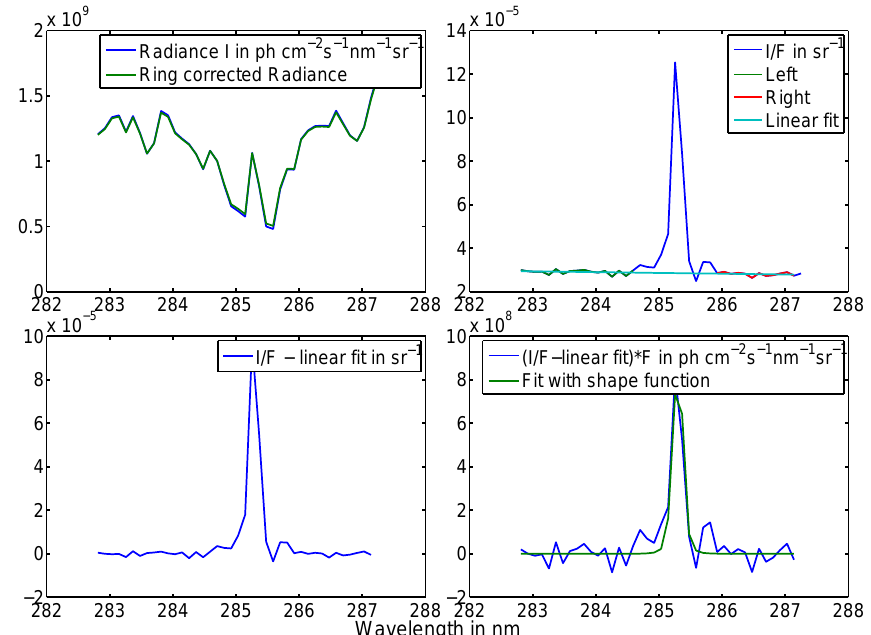
Fig. 3. Slant column emission (SCE) determination. First the Ring effect correction is applied to the limb radiance I (top left panel). The limb radiance is divided by the solar irradiance F and the wavelength region left and right to the line are used for a linear fit of the background radiation (top right panel). The linear fit is subtracted from the ratio I/F (bottom left panel) and the spectrum is again multiplied with the solar irradiance F (bottom right panel). Finally the area of the emission line is fitted with the slit function of the instrument.